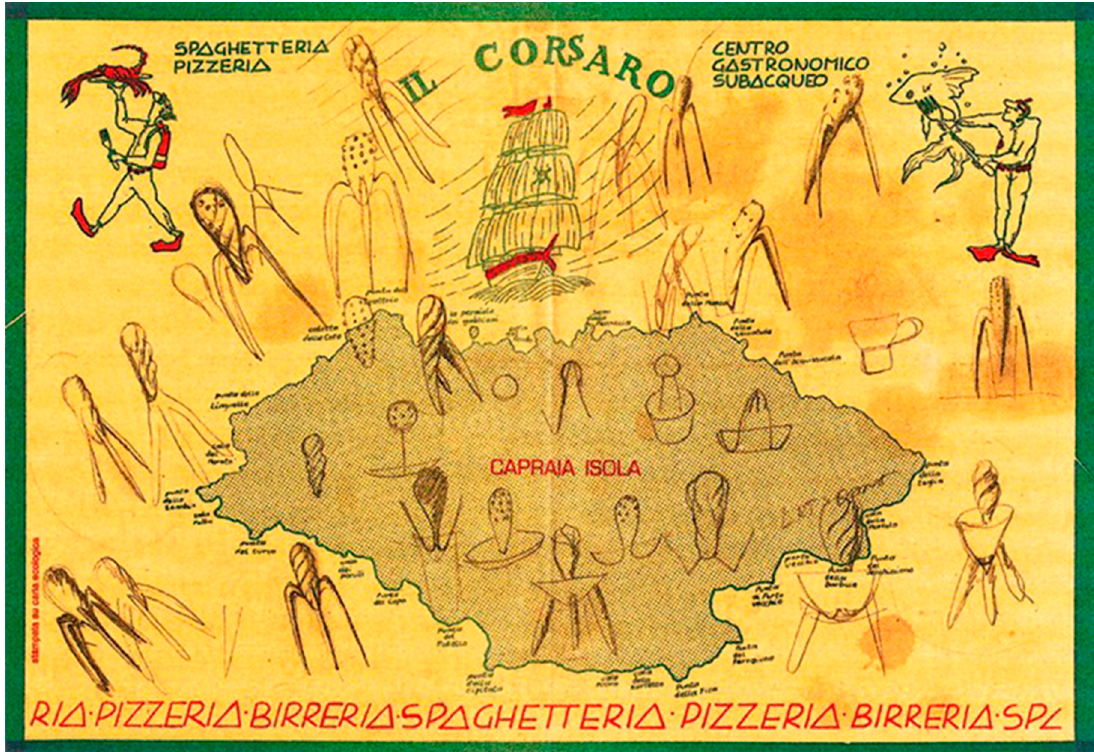
Figure 2 . Starck’s original design sketches for the Alessi lemon squeezer. Figure 2. Starck’s original design sketches for the Alessi lemon